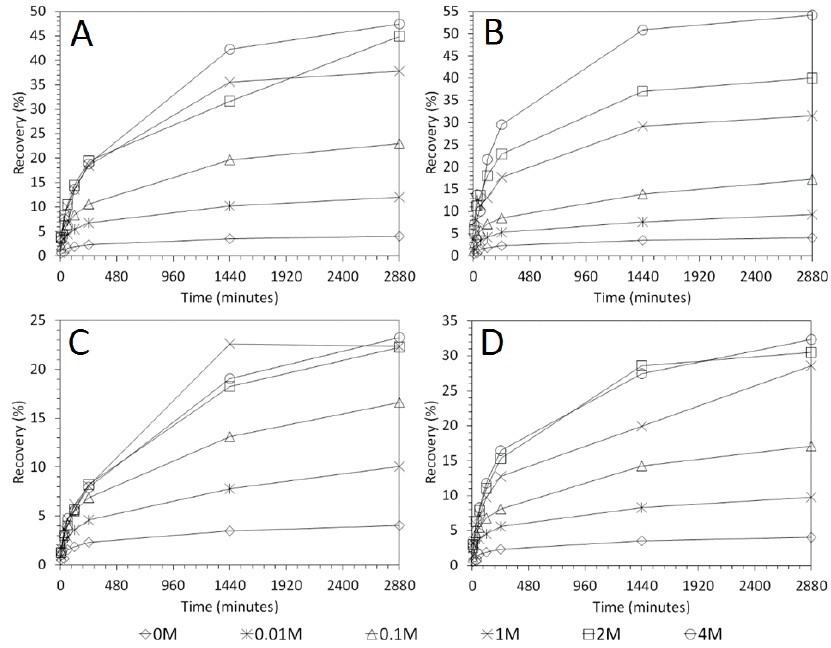
Figure 6. Cu recovery as a function of time and acid concentration for: H 2 SO 4 ( A ), HCl ( B ), C 6 H 8 O 7 ( C ) and CH 3 SO 3 H ( D ). A solid – liquid ratio of 0.1 and lixiviant volume of 200 mL were used for each experiment.